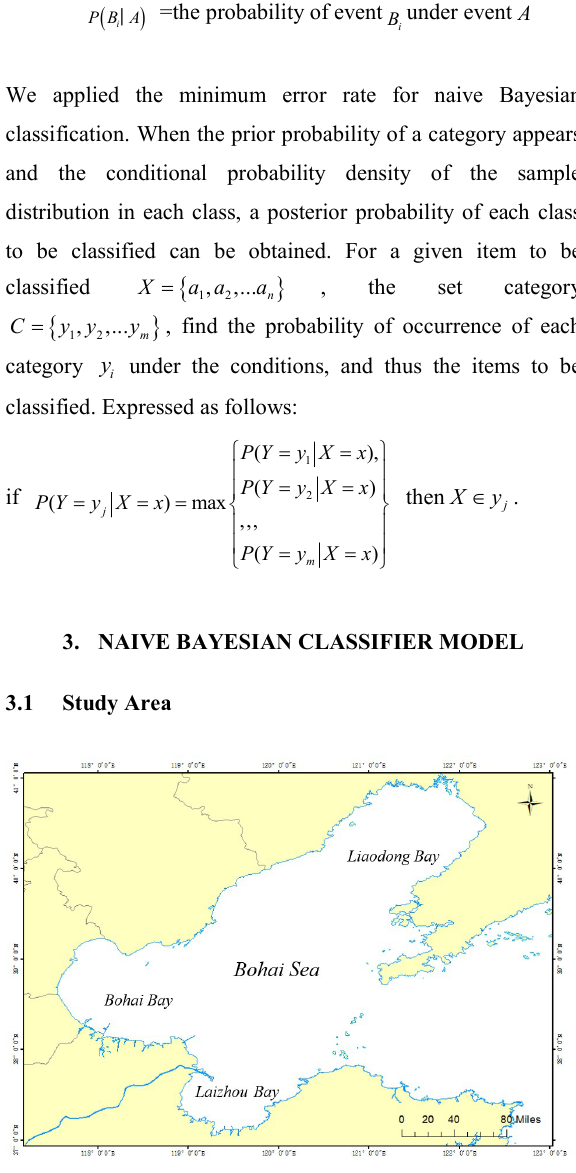
Figure 1. Distribution of oil spills in the Bohai area